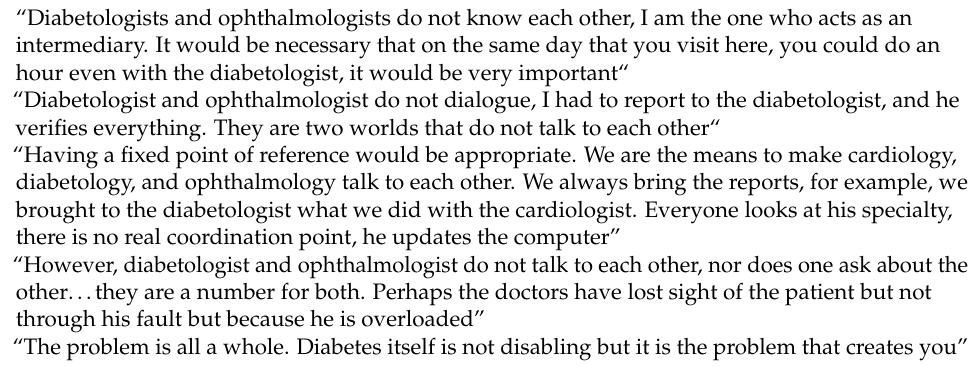
Table 3. Lack of the multidisciplinary